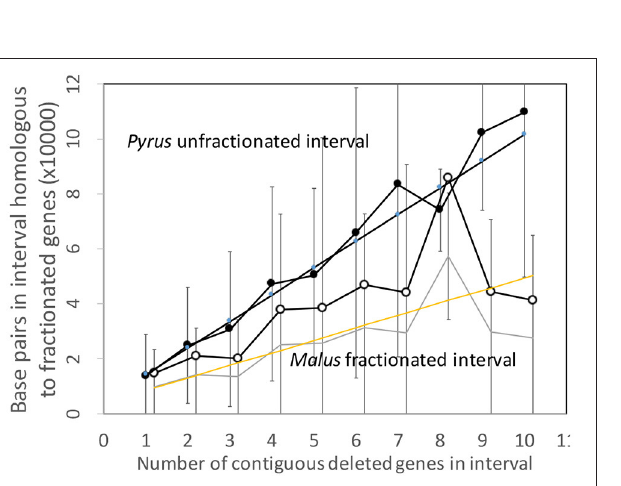
that gene density (or rather its inverse: base pairs per length